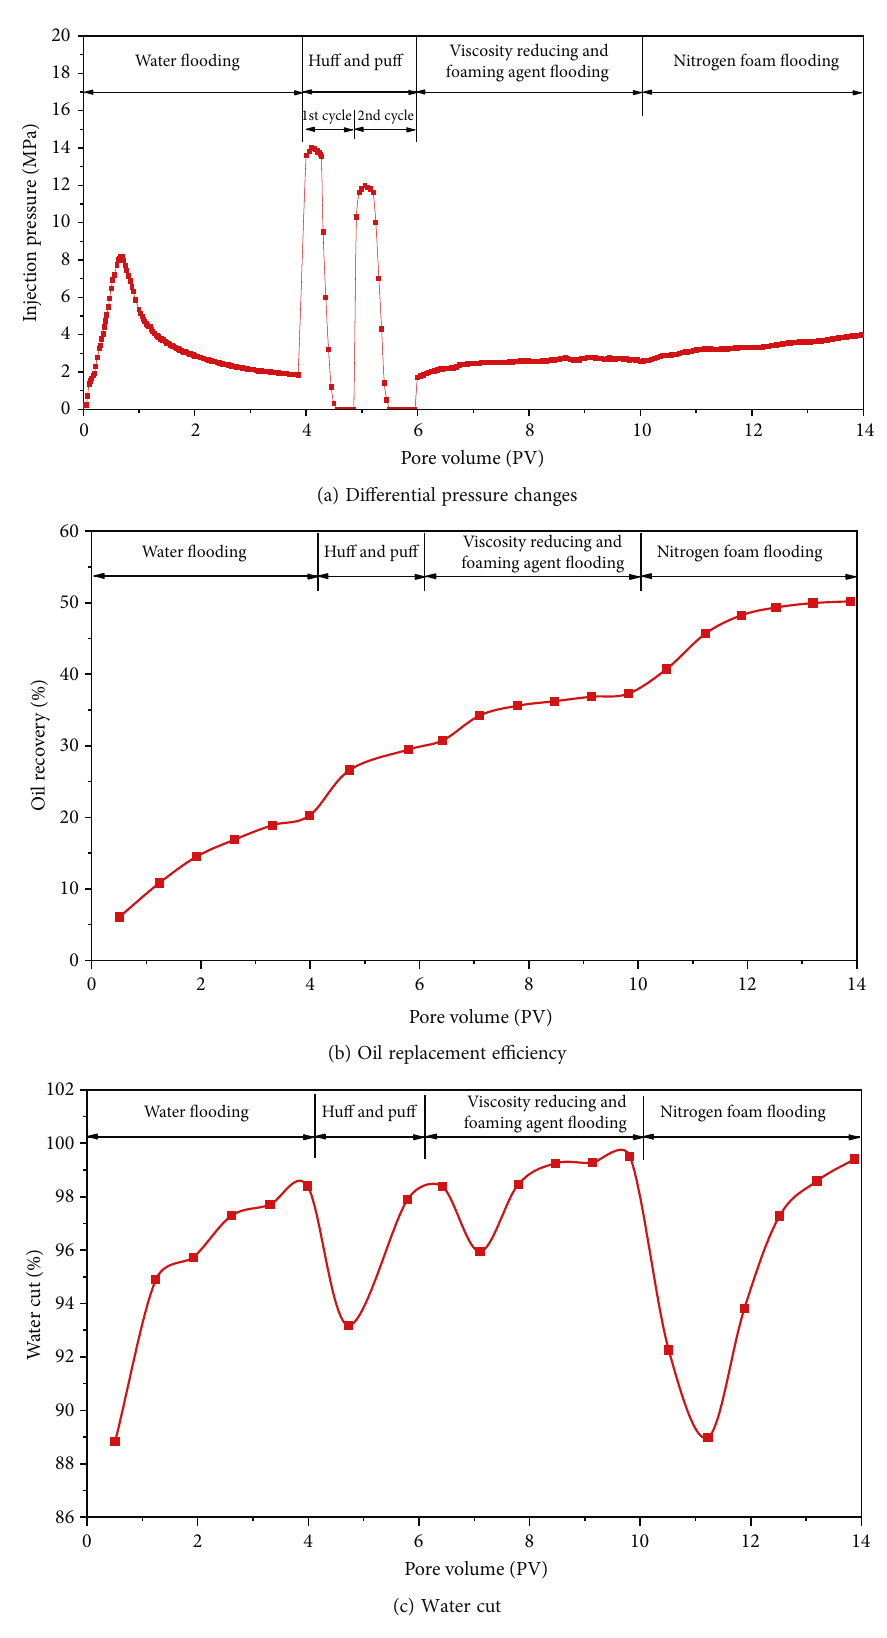
Figure 10: Results curve of core fl ooding